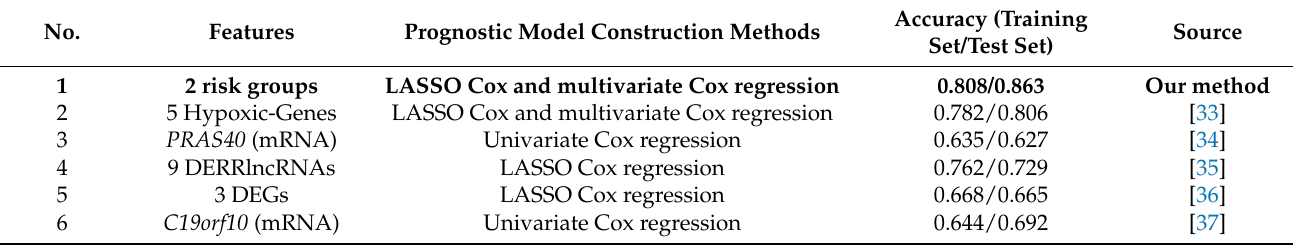
Table 2. Classification results obtained by different prognostic model in KIRC